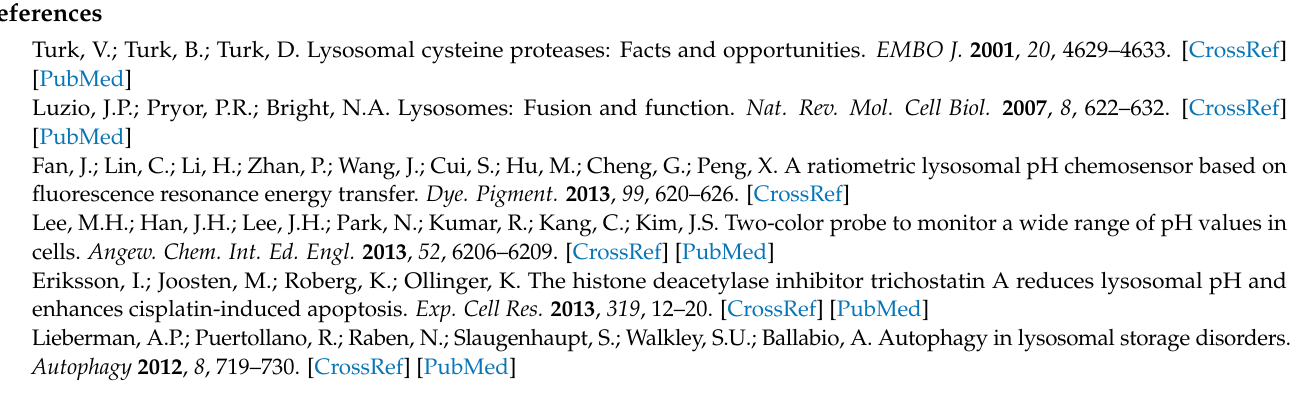
Figure S2: DLS profile and TEM images of mPEG-b-P(PA-alt-AGE) copolymer micelles; Figure S3: Polymer micelles stability test of mPEG-b-P(PA-alt-AGERh) measured by DLS; Figure S4: UV–vis absorption spectra recorded for a rhodamine-functionalized mPEG-b-P(PA-alt-AGERh) copolymer micelles solution (1.5 mg/mL) at different pH or in the presence of different kinds of metal ions (tris-buffer pH 7.0, 100 µ M); Absorbance changes at 561 nm recorded for the micelle solution of rhodamine-functionalized mPEG-b-P(PA-alt-AGE) (1.5 mg/mL) at different pH or upon addition of 100 µ M of various metal ions (tris-buffer pH 7.0); Figure S5: Photographs recorded under visible light for micelle solutions of rhodamine-functionalized mPEG-b-P(PA-alt-AGERh) (1.5 mg/mL) at different pH or in the presence of different kinds of metal ions (tris-buffer pH 7.0, 100 µ M); Figure S6: Cell viability of rhodamine-functionalized mPEG-b-P(PA-alt-AGERh) copolymer micelles determined by MTT analysis. Cells were incubated with different concentrations (0–100 µ g mL − 1 ) of micelles for 8 and 24